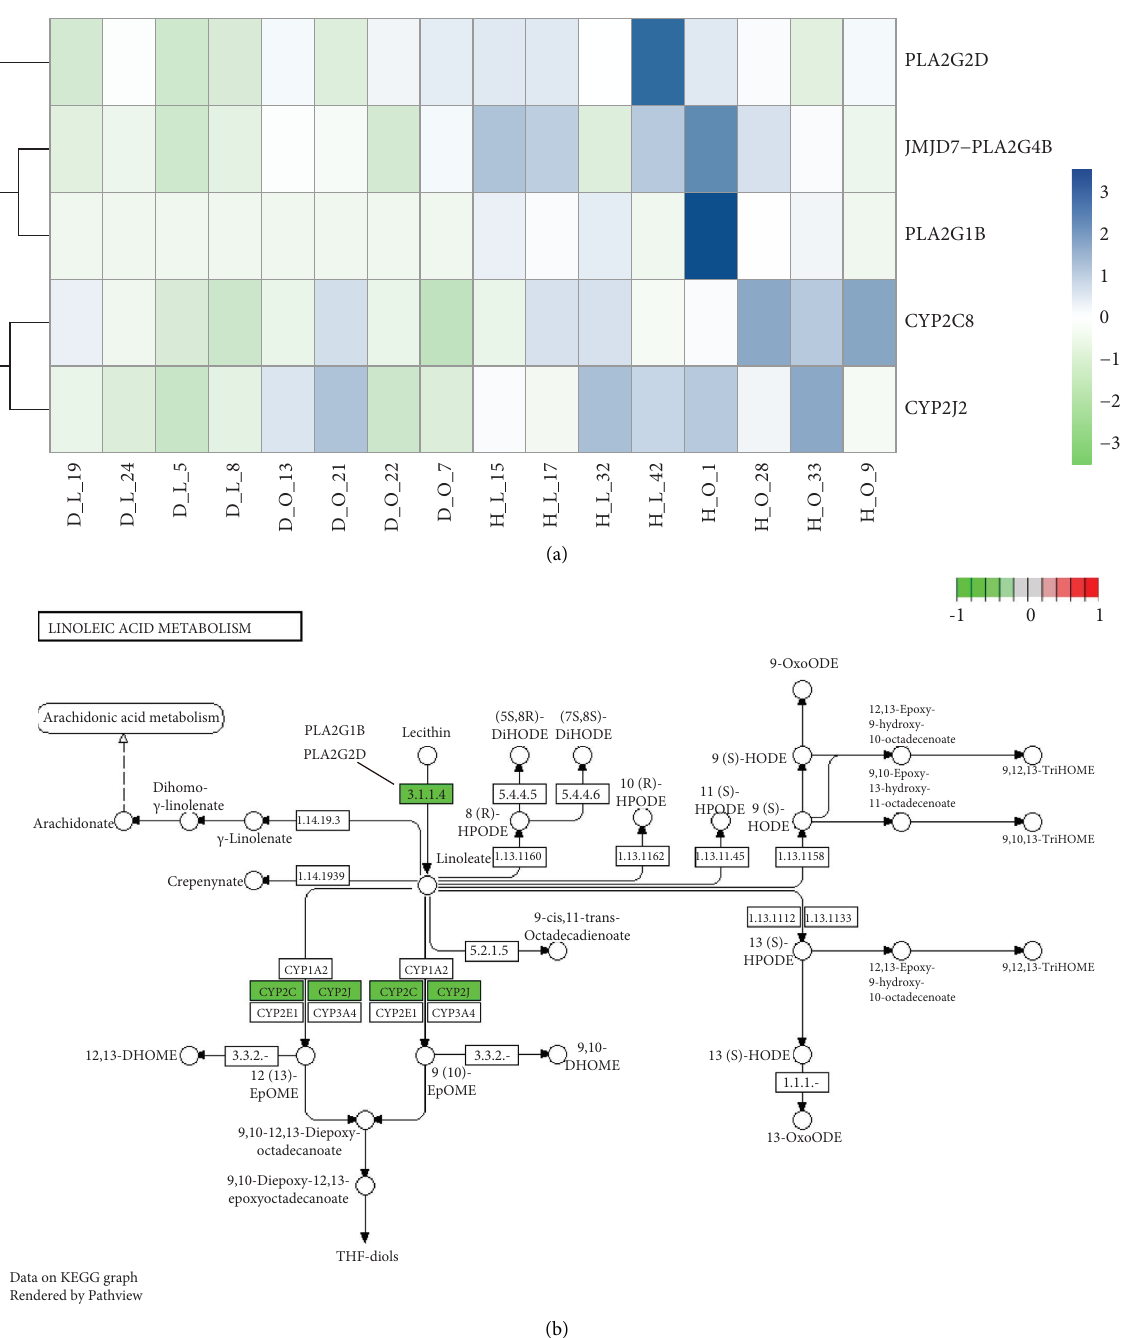
Figure 3: Linoleic acid metabolism pathway visualization. (a) Signifcantly downregulated genes involved in the linoleic acid metabolism pathway. (b) Linoleic acid metabolism pathway visualization with mapped data of